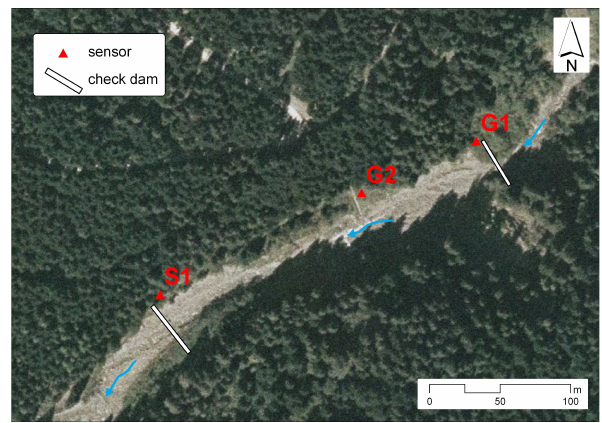
Fig. 2. Plan view of the channel reach instrumented with seismic sensors. The labels G1 and G2 indicate the upstream detectors (geo- phones type 2) and S1 the downstream seismometer (type 1).